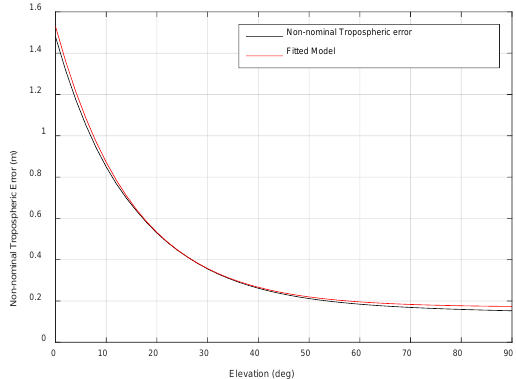
Figure 12. Non-nominal tropospheric error and fitted model.